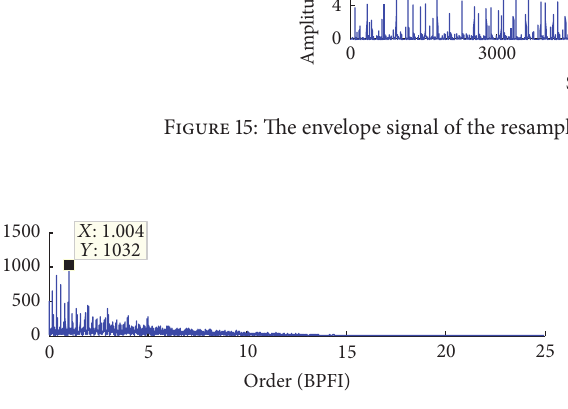
Figure 16: The order envelope demodulation spectrum of the inner race vibration signal.